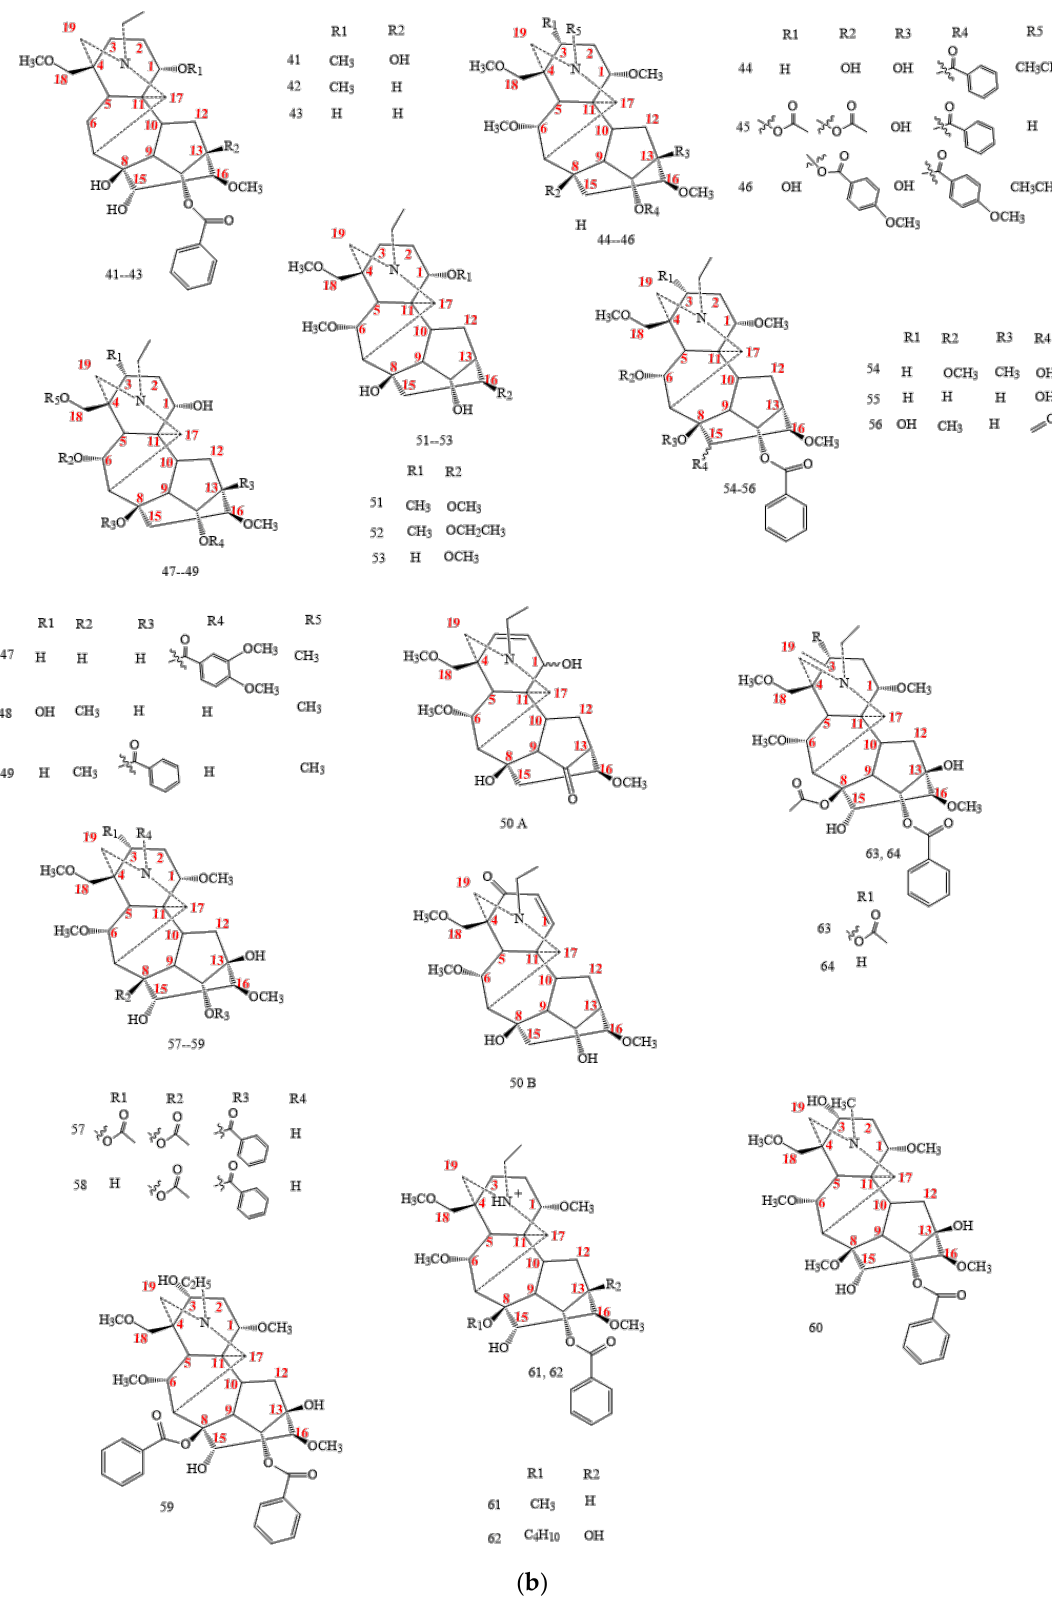
Figure 5. ( a ) C 19 -aconitine Das, structures 22–40 . ( b ) C 19 -aconitine Das, structures 41–62 .